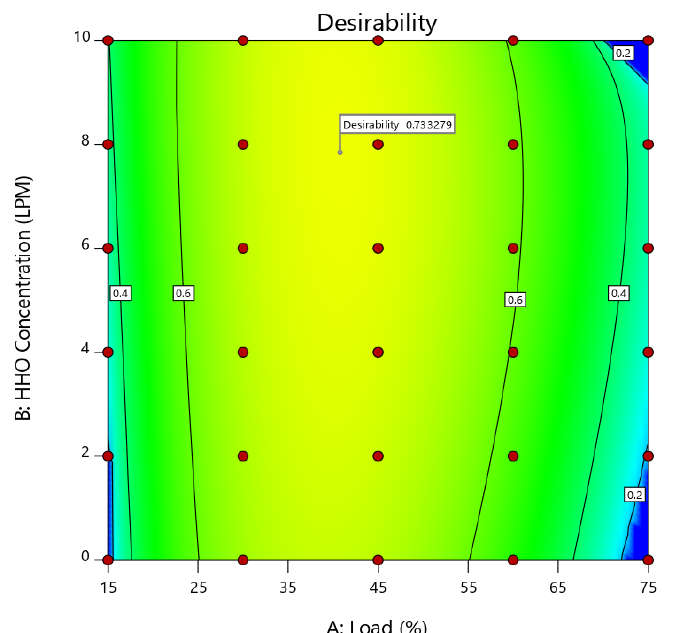
Figure 15. Contour plot of desirability.